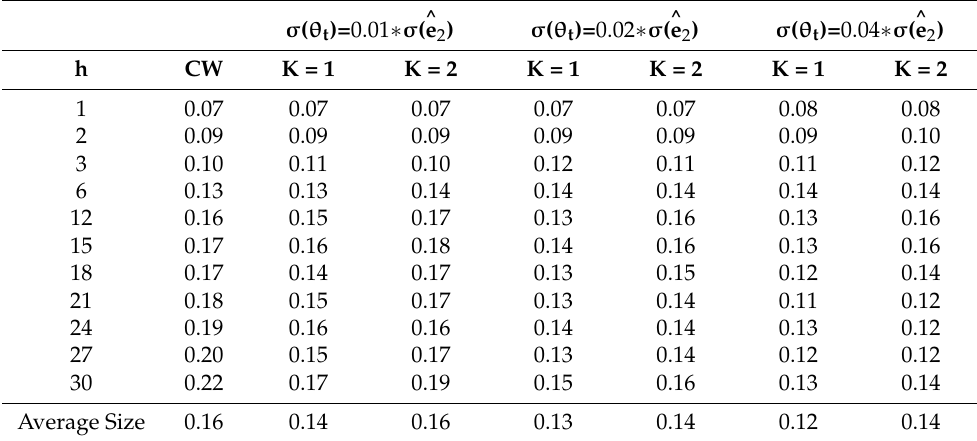
Table 6. Empirical size comparisons between CW and WCW tests with nominal size of 10%, consid- ering DGP3 and a small